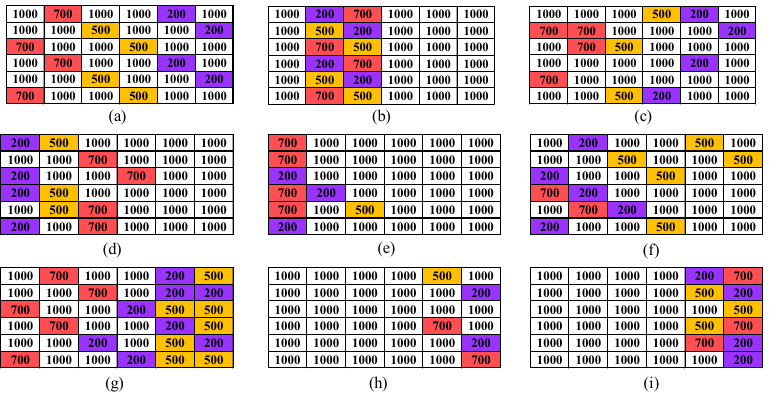
Figure 6. Shade spreading due to NSD method ( a ) case II, ( b ) case III, ( c )case IV, ( d ) case V, ( e) case VI, ( f ) case VII, ( g )case VIII, ( h ) case IX, ( i ) case X.